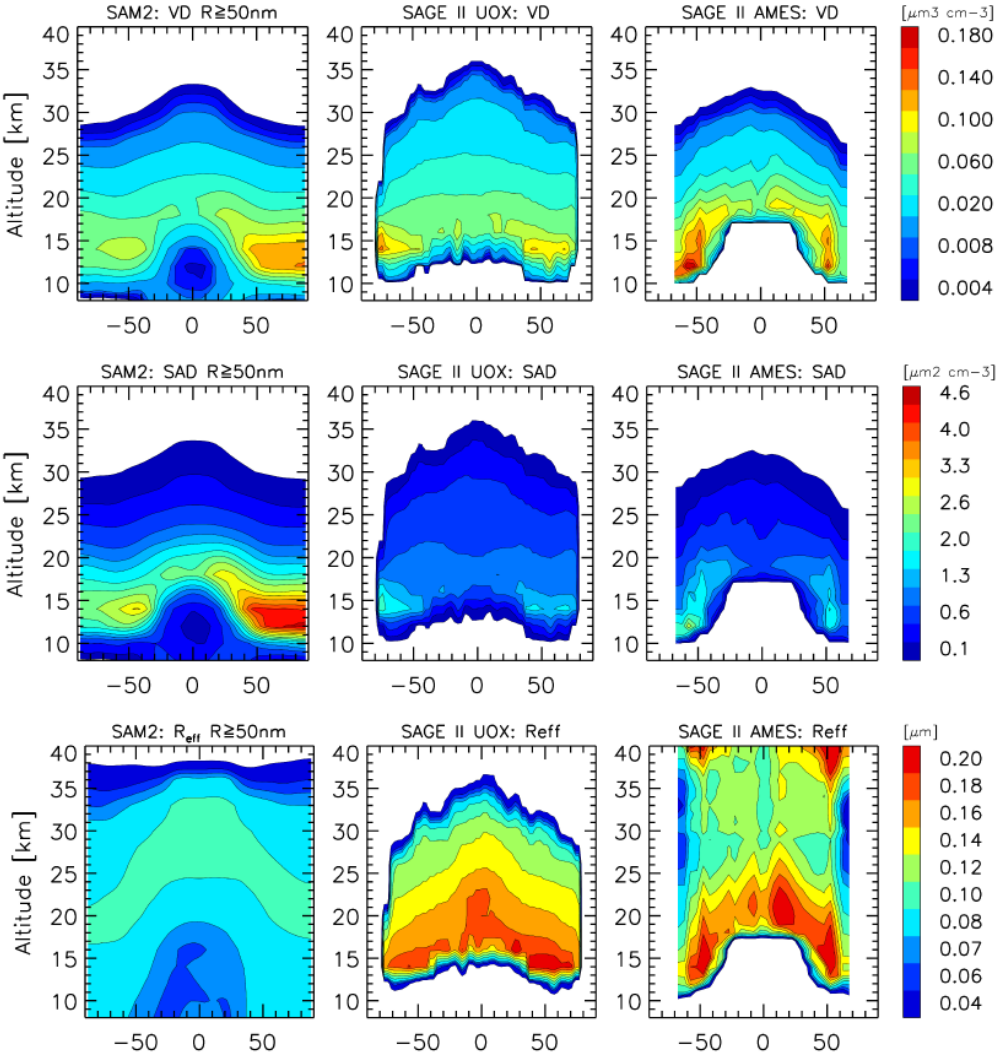
Fig. 9. Modelled climatologies (left column) of aerosol volume density (upper row), aerosol surface area density (middle row), and effective radius (bottom row), in comparison with SAGE II retrievals of the University of Oxford (Wurl et al., 2010, middle column) and NASA AMES laboratory (Bauman et al., 2003a,b, right column). All data for 1998 as zonal annual